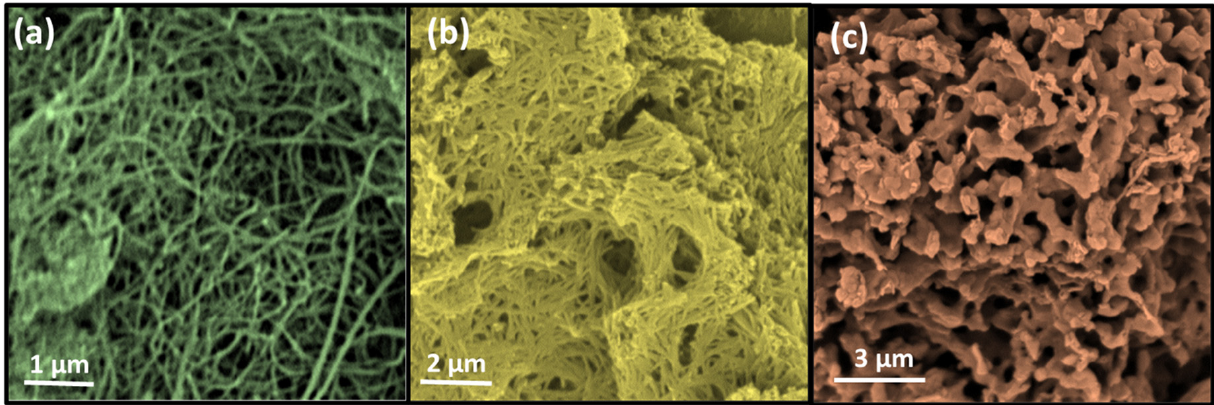
Figure 5. SEM images of BNNT synthesized at 1200 °C ( a ), 1350 °C ( b ) and 1500 °C ( c ).